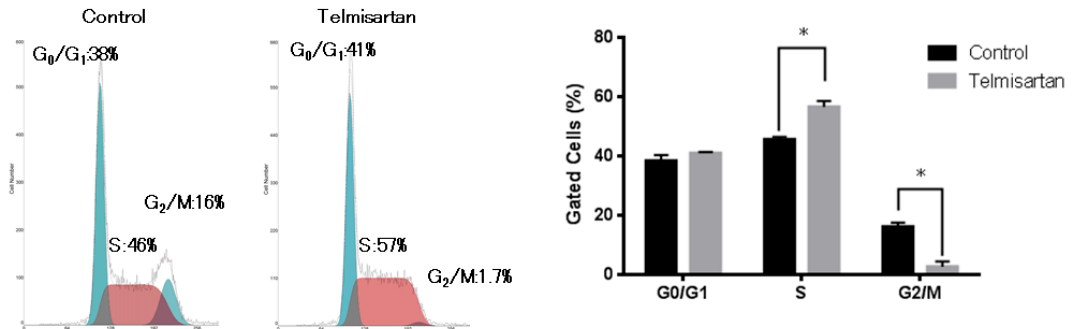
Figure 2. Flow cytometric analysis of KYSE180 cells treated with 50 µM telmisartan at 24 h. Telmisartan increased the population of cells in the S phase and decreased the population of cells in the G 2 /M phase. Telmisartan blocks cell-cycle progression to G 2 /M from S phase. (* p < 0.01).